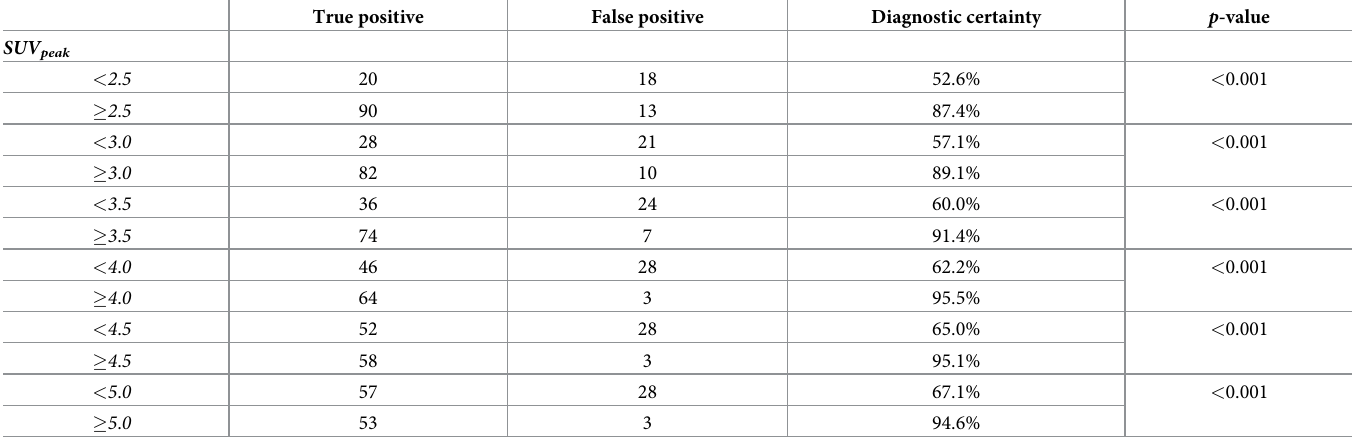
Table 5. Comparison of the diagnostic certainty, stratified per